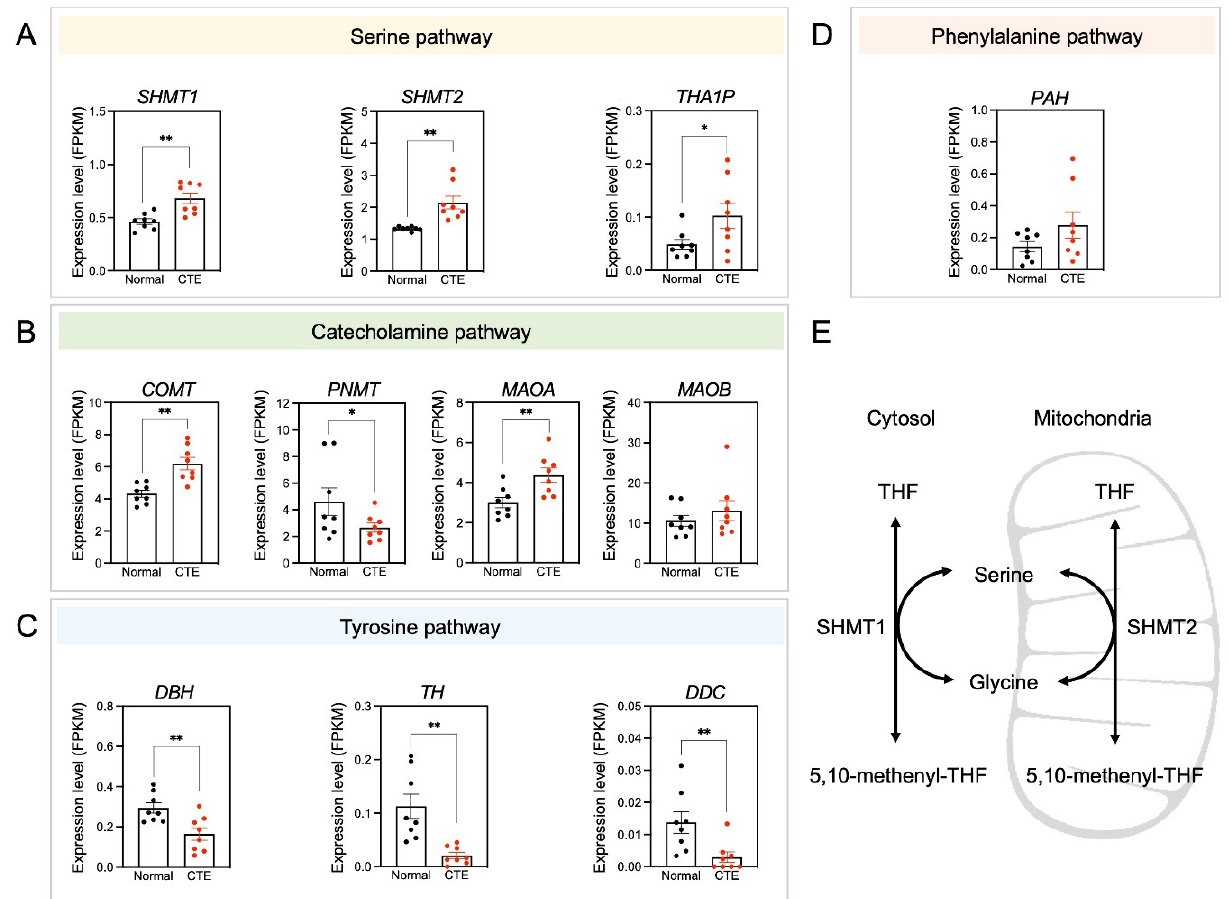
Figure 5. Amino acid neurotransmitter-associated genes are altered in CTE patients. ( A ) The expression levels of SHMT1 , SHMT2, and THA1P were increased in CTE patients. ( B ) The expression levels of COMT and MAOA were increased but PNMT was decreased in CTE patients. ( C ) The expression levels of DBH , TH, and DDC were decreased in CTE patients. ( D ) The expression level of PAH was not different between CTE patients and normal subjects. ( E ) A scheme illustrating that serine is produced by SHMT1 in the cytosol and SHMT2 in the mitochondria. Significantly different from the normal subjects at * p < 0.05; ** p < 0.01.